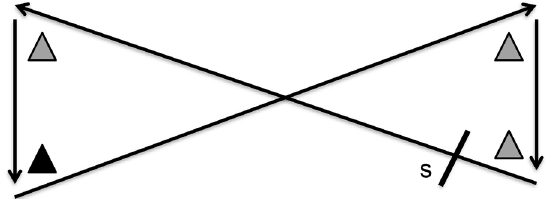
Figure 1. Closed course diagram for the two-min- ute test adopted from Pitchford and Yun (2011). “S” represents the starting